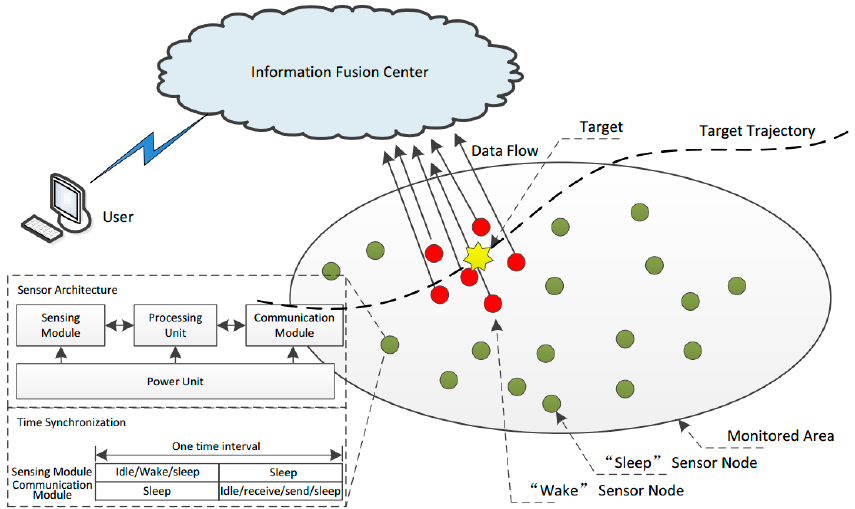
Figure 1. The problem formulation of sensor wake-up and architecture of a sensor node.